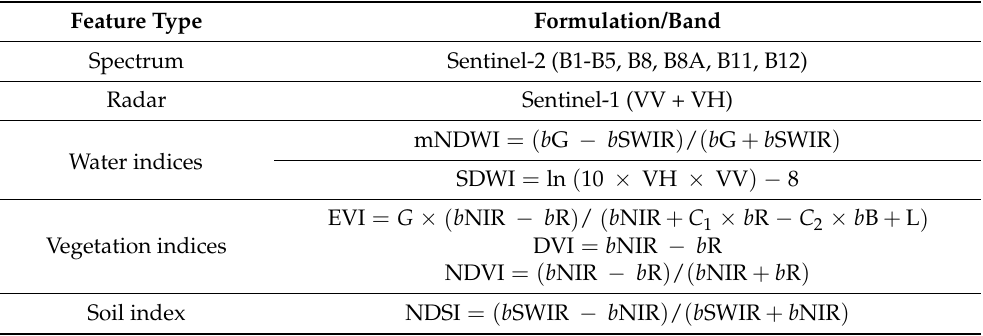
Table 2. Input feature set for the random forest algorithm for seaweed